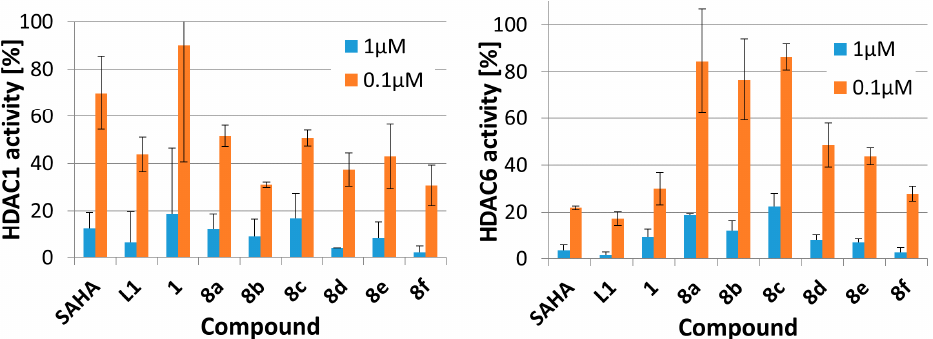
Figure 2. HDAC1 and HDAC6 inhibition assays of Ru complexes 1 and 8a – f , and control compounds, measured using commercially available assay kits. All assays carried out in triplicate. See Supplementary Materials for details.